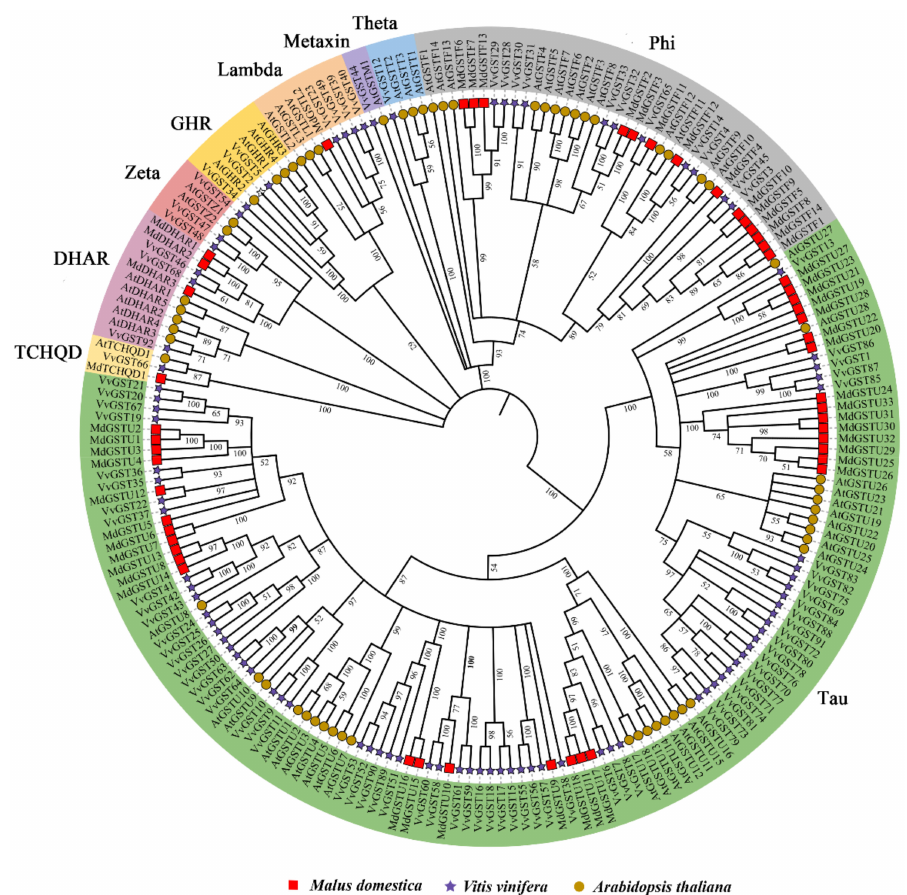
Figure 1. Phylogenetic tree constructed with 92 GST protein sequences with the GST genes from Arabidopsis thaliana and Malus domestica . Different colors represent different subfamilies of GST genes, different shapes indicate different species. The MEGA X software was used to construct the tree using the neighbor-joining